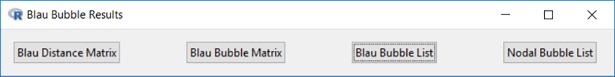
Results from Blau bubble analysis.